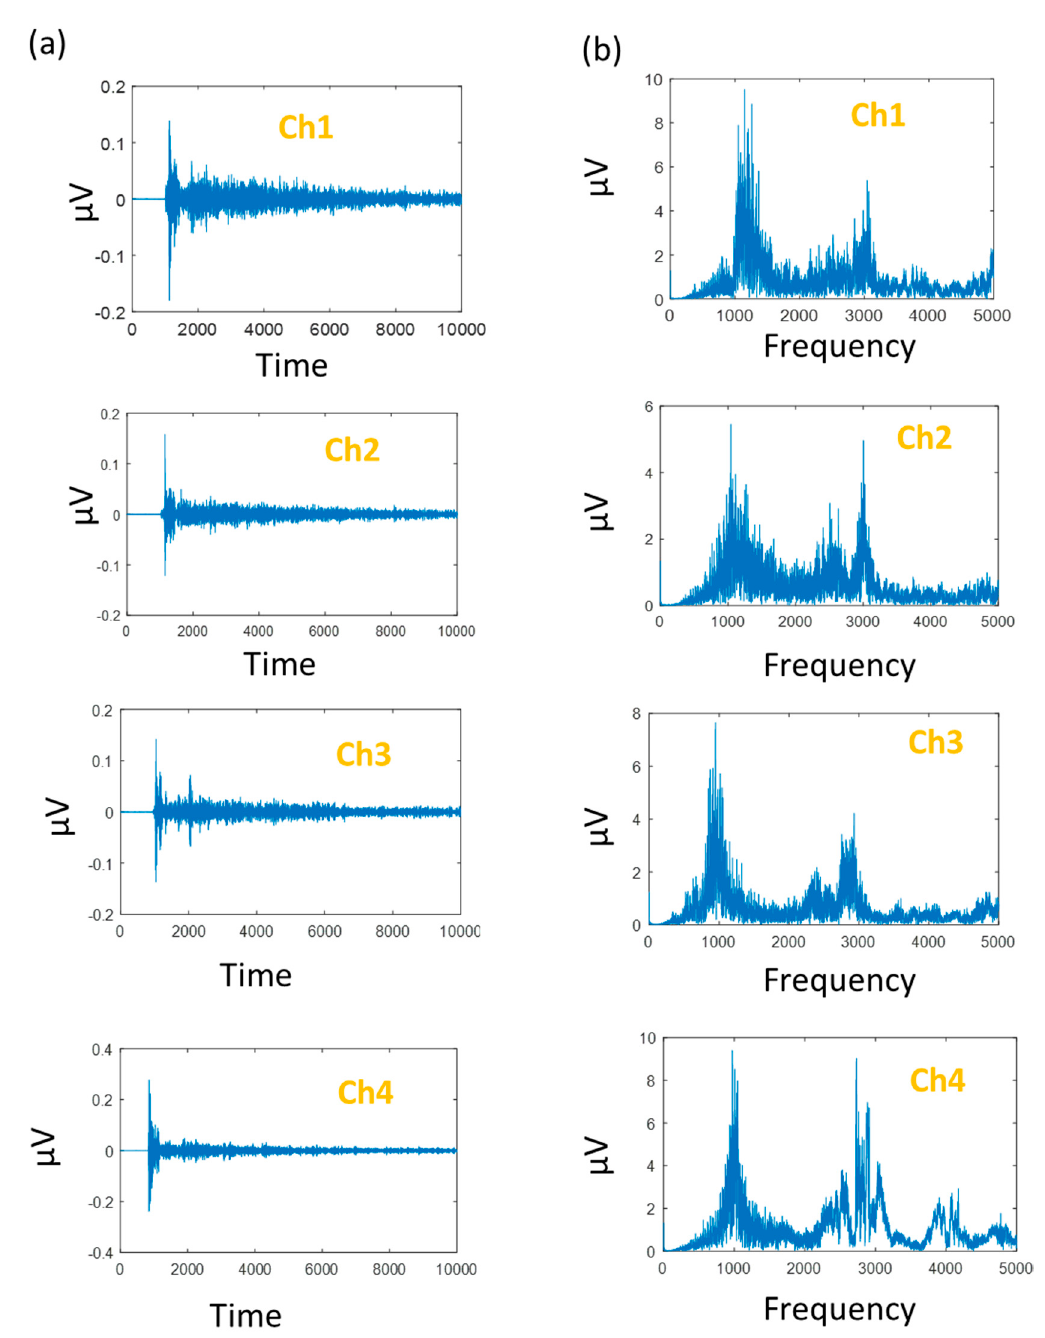
Figure 9. ( a ) Time-domain pressure vessel AE signals and ( b ) corresponding frequency-domain signals of the signals in (a).